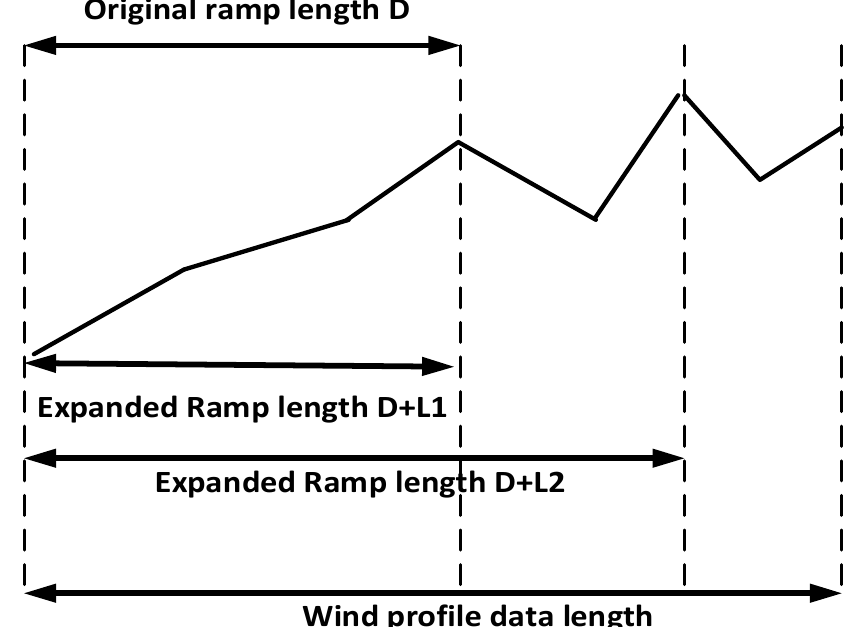
Figure 4. The principle of the improved ramp length extension and contraction strategy single ramp wind shear detection algorithm.